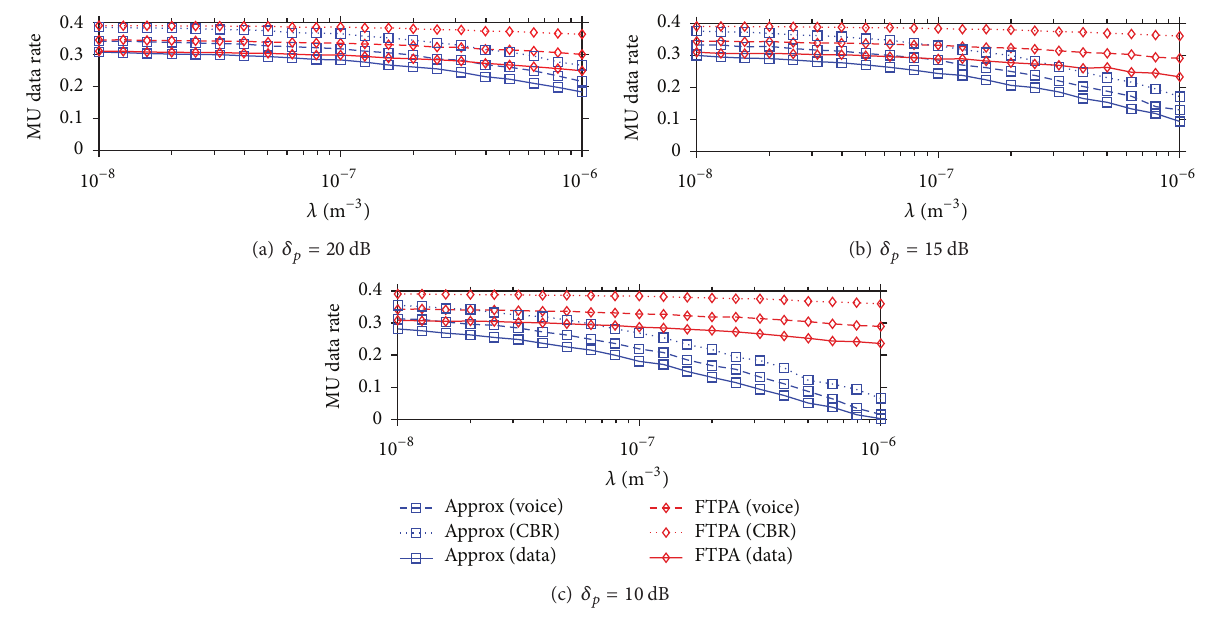
Figure 9: MU data rate achieved by FTPA and Approx versus the FBS deployment density under different 𝛿 𝑝